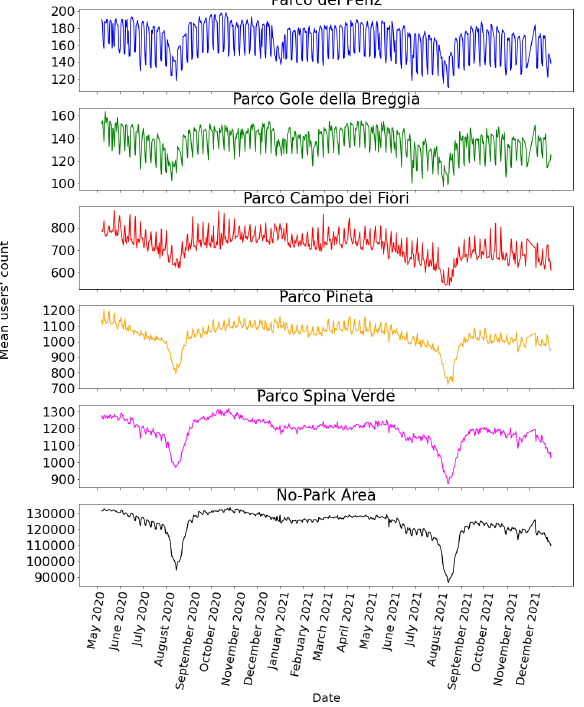
Figure 2. Time series of daily mean Facebook users’ counts by